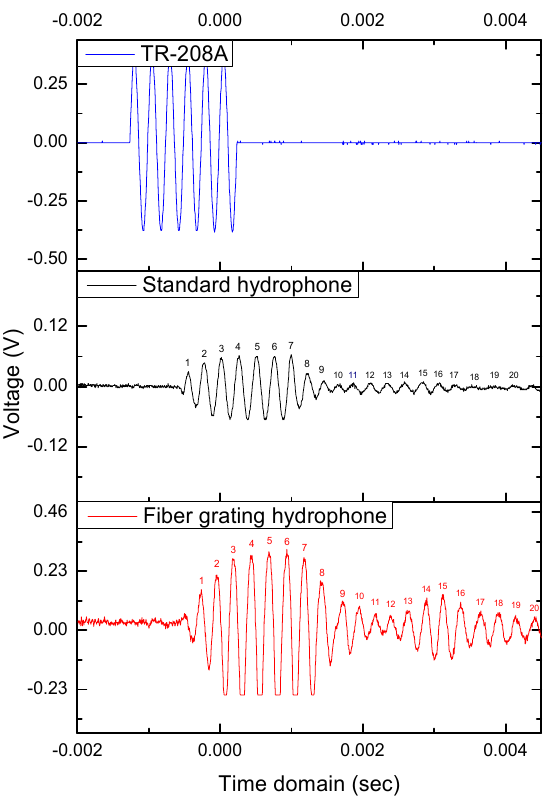
Figure 8. Electrical signals for a frequency of 4 kHz.